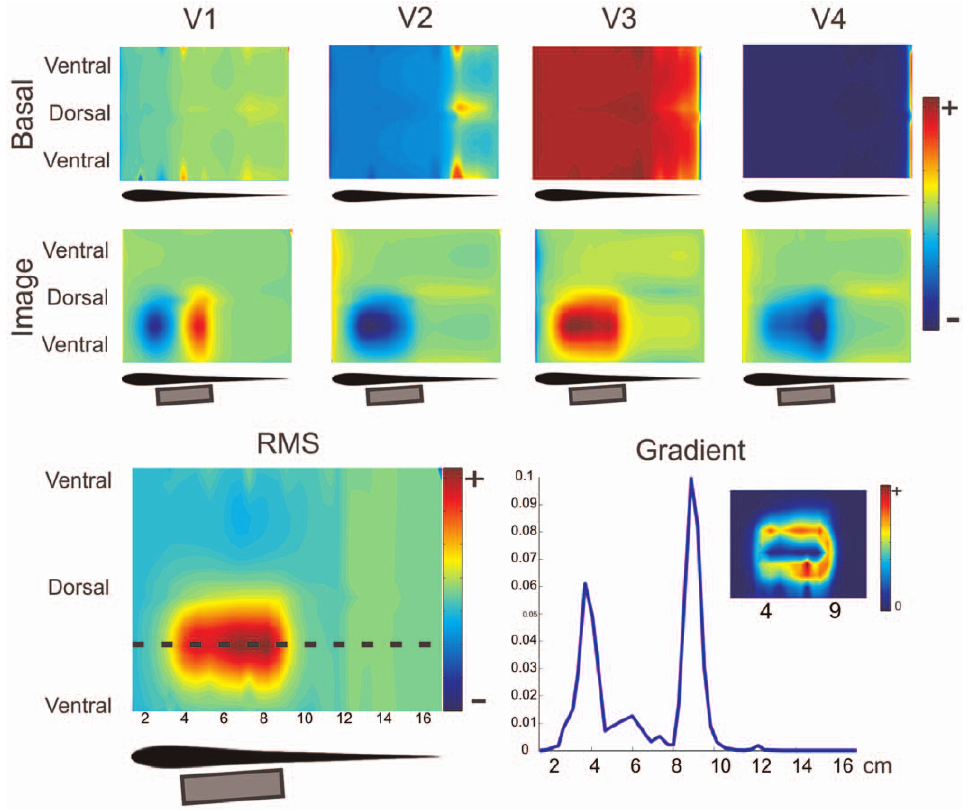
Figure 8. Image of a large metal object. Two dimensional plots correspond to the images on the skin, where it was cut through the ventral intersection with the saggital plane, stretched perpendicularly to the longitudinal axis, to cover a rectangle. The horizontal scale corresponds to the distance in cm from the frontal tip along the skin through the horizontal plane. Top: Images generated on the skin of MoGO by a 2 by 5 cm cylinder placed almost parallel to the lateral skin at different instances of the EOD corresponding to the peaks of the four main components. Top Row: images, at the head and trunk regions, of the basal currents for each wave. Bottom Row: the electric image (at the same region) as the difference between currents with and without the cylinder. Bottom Left: RMS image of MoGO’s body. Bottom Right: Longitudinal profile of the gradient of the RMS electric image showing two peaks signaling the position of the edges of the object. Inset: 2D mapping of the gradient of the RMS image shows the correlation between high gradient and the edges of the object.